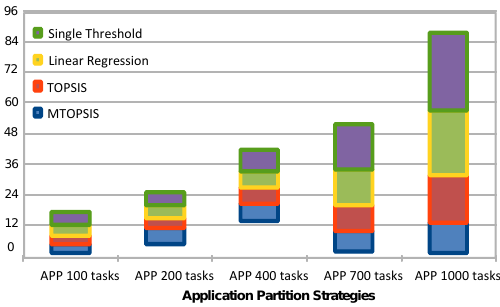
Figure 5. Application Partitioning Accuracy